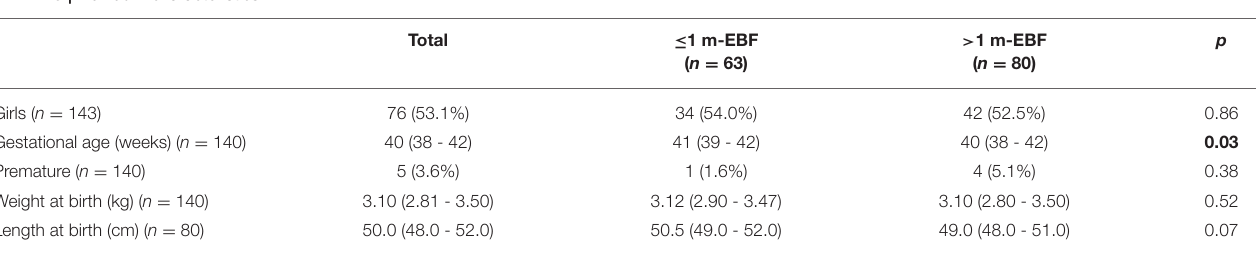
TABLE 3 | Newborn